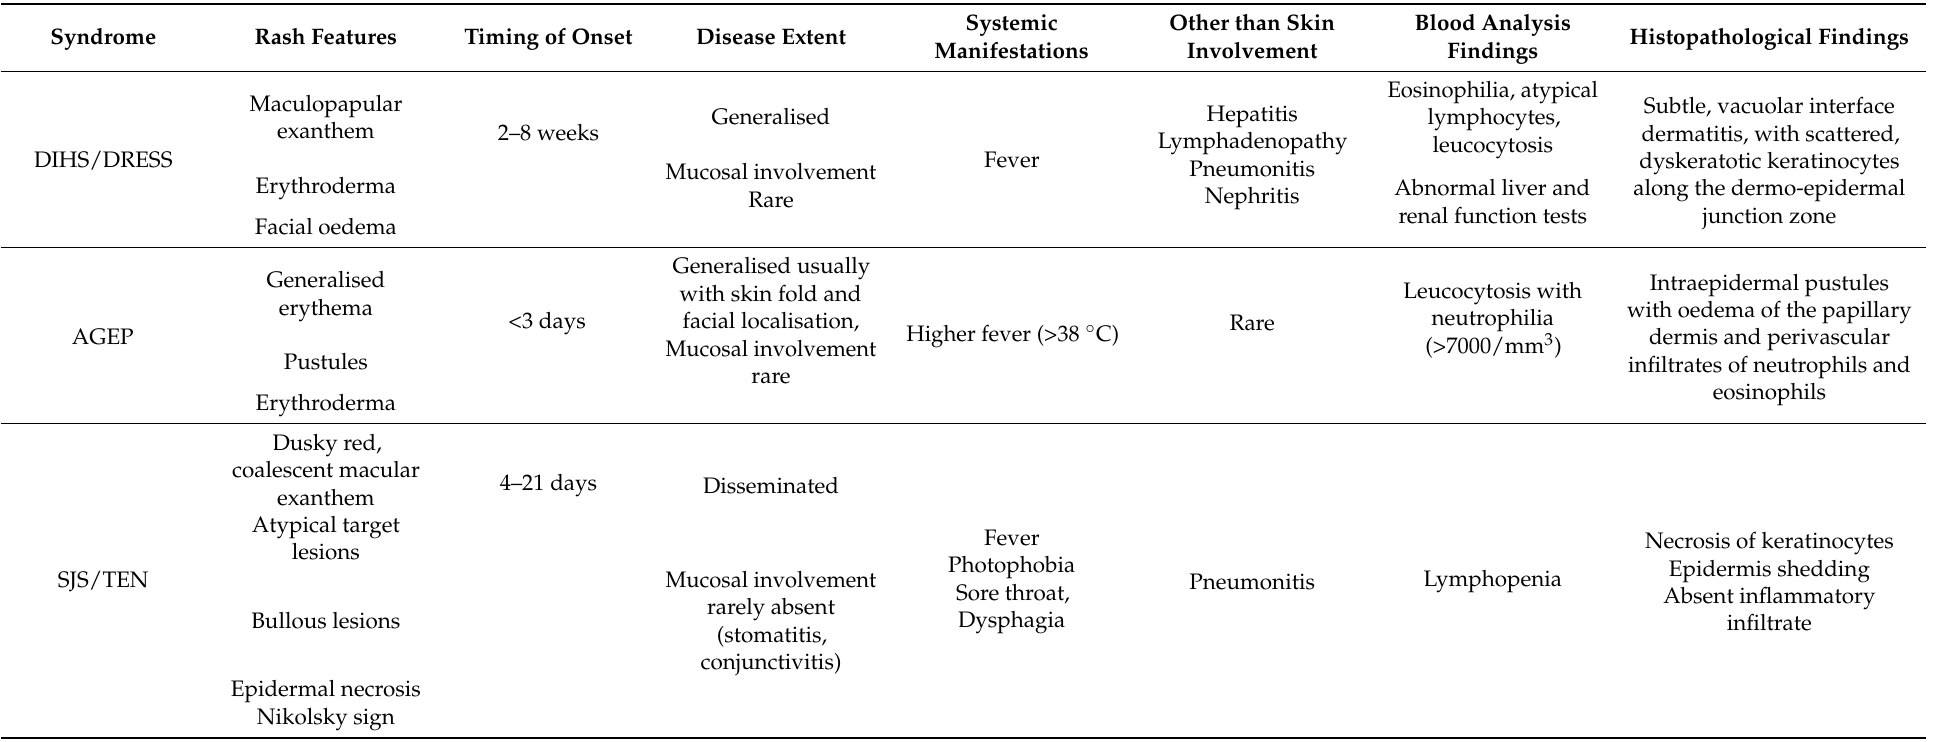
Table 3. Differential skin manifestations among DRESS and other